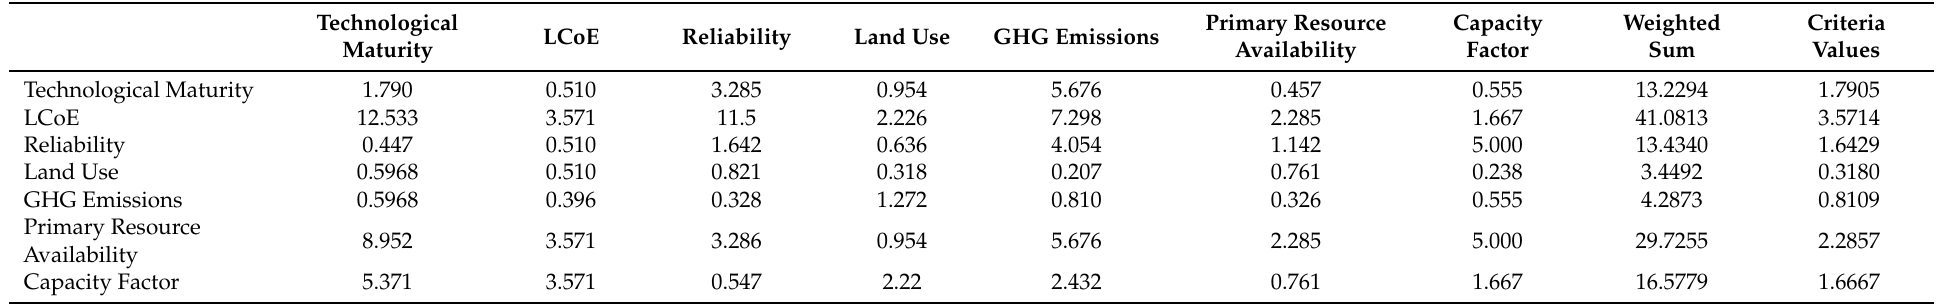
Table 1. Consistency matrix of the AHP. The most important sub-criteria for the technology selection process from [22,24,27,28].